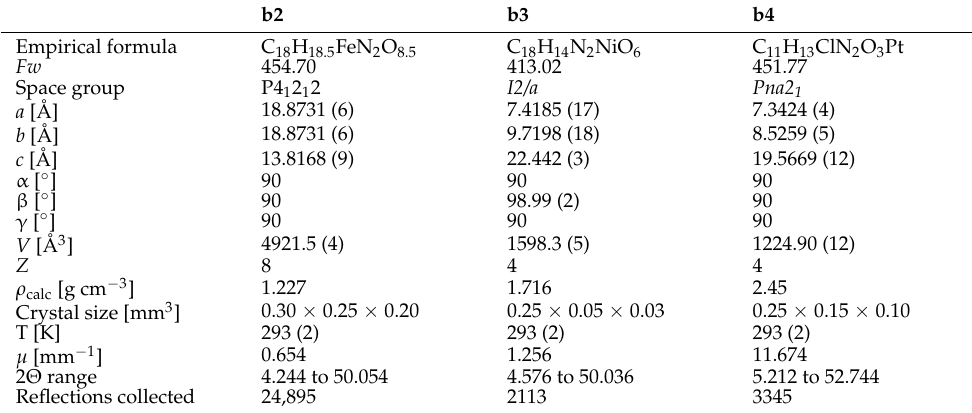
Figure 2. SC XRD analysis for compounds b2 – b4 (symmetry code: *—3/2 − x , + y , 1 − z ). Table 2. Crystal data and details of data collection for the b compounds.